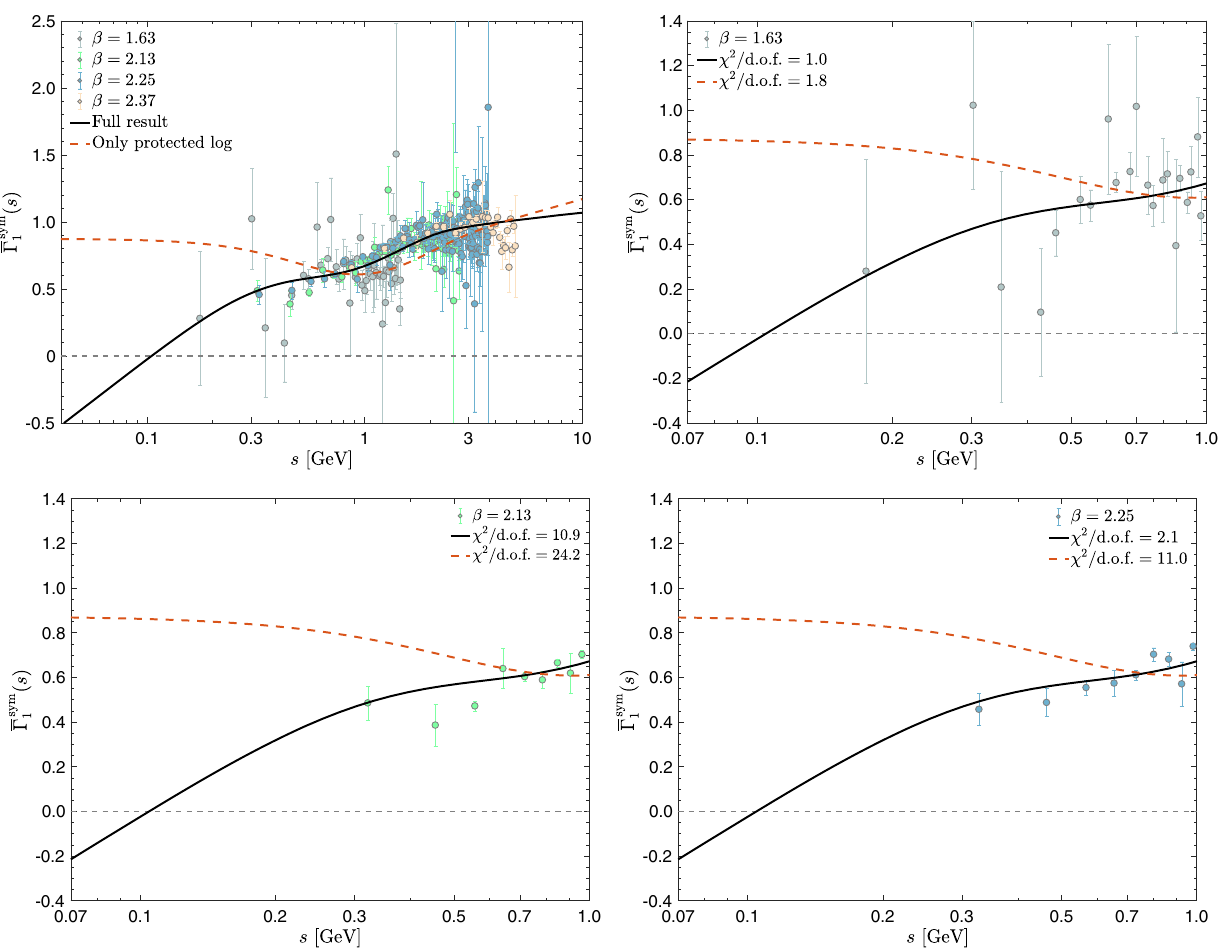
χ 2 / d.o.f. when we compare the lattice data for β = 1 . 63 with the results for (cid:2) sym 1 ( s ) with (black continuous) and without (red dashed) the unprotected logarithm. Bottom left plot: The same as the previous panel but for the lattice data with β = 2 . 13. Bottom right plot: Same analysis, using the lattice data with β = 2 .